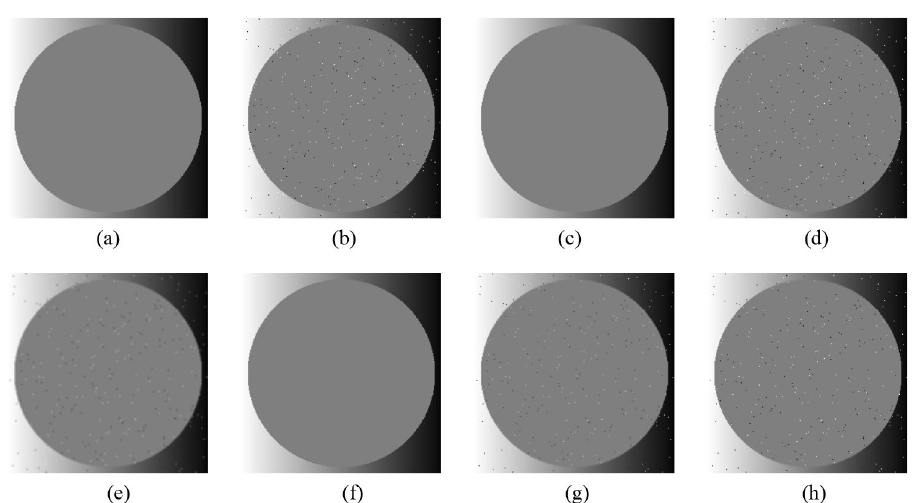
Figure 7. Comparison of the denoising performance of each filter against the salt-and-pepper noise (“Geometric pattern”). ( a ) Original image; ( b ) noise-added image; ( c ) filtered image using abwFMGFI; ( d ) filtered image using NLMF (templateWindowSize: 21, searchWindowSize: 7); ( e ) filtered image using GF (σ_x: 5, σ_y: 5); ( f ) filtered image using MF; ( g ) filtered image using BF (σ_c: 35, σ_s: 5); ( h ) filtered image